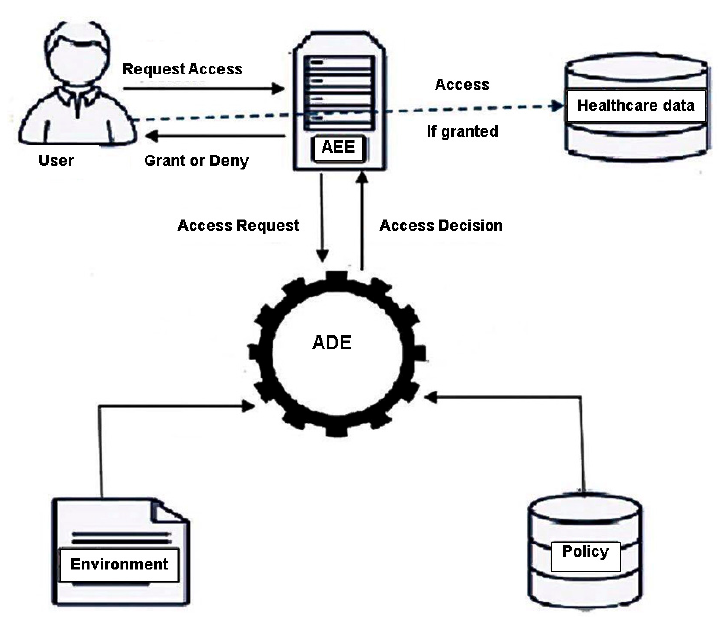
Figure 3. Architecture Model.